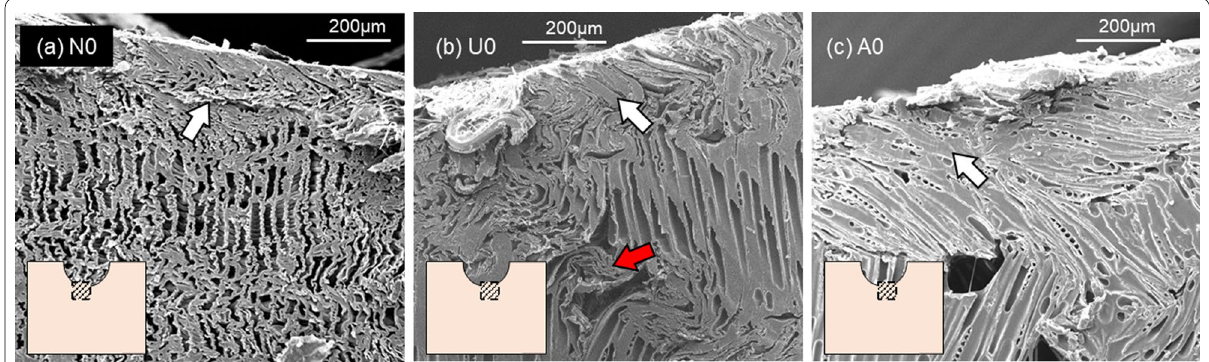
Fig. 7 SEM images for clarifying where the deformation occurred. The illustrations at the lower left on each image indicate where the cube was removed from the specimens. White arrows show the examples of the wood cells in the vicinity of the steel bar. Red arrow indicates the deformed part in urethane-impregnated